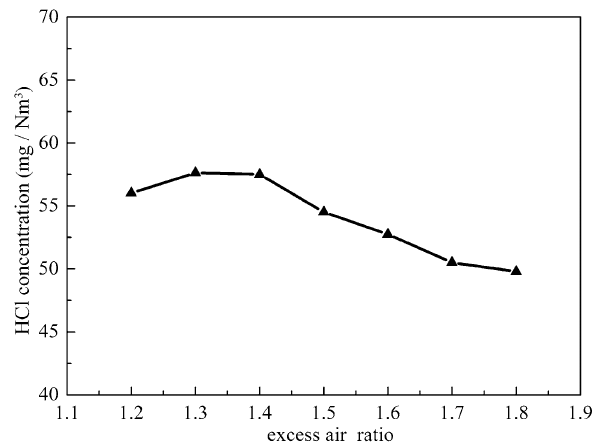
Fig. 10 Effect of excess air ratio on the HCl